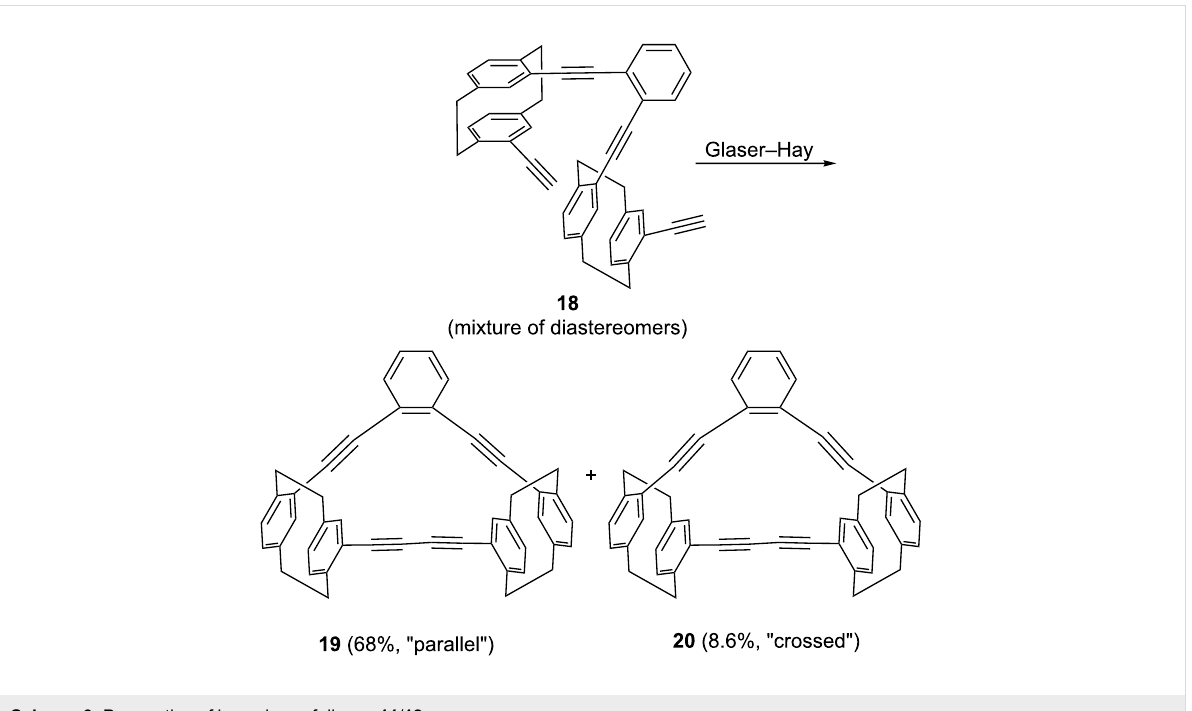
Scheme 6: Preparation of benzologs of dimers 11 / 12 .